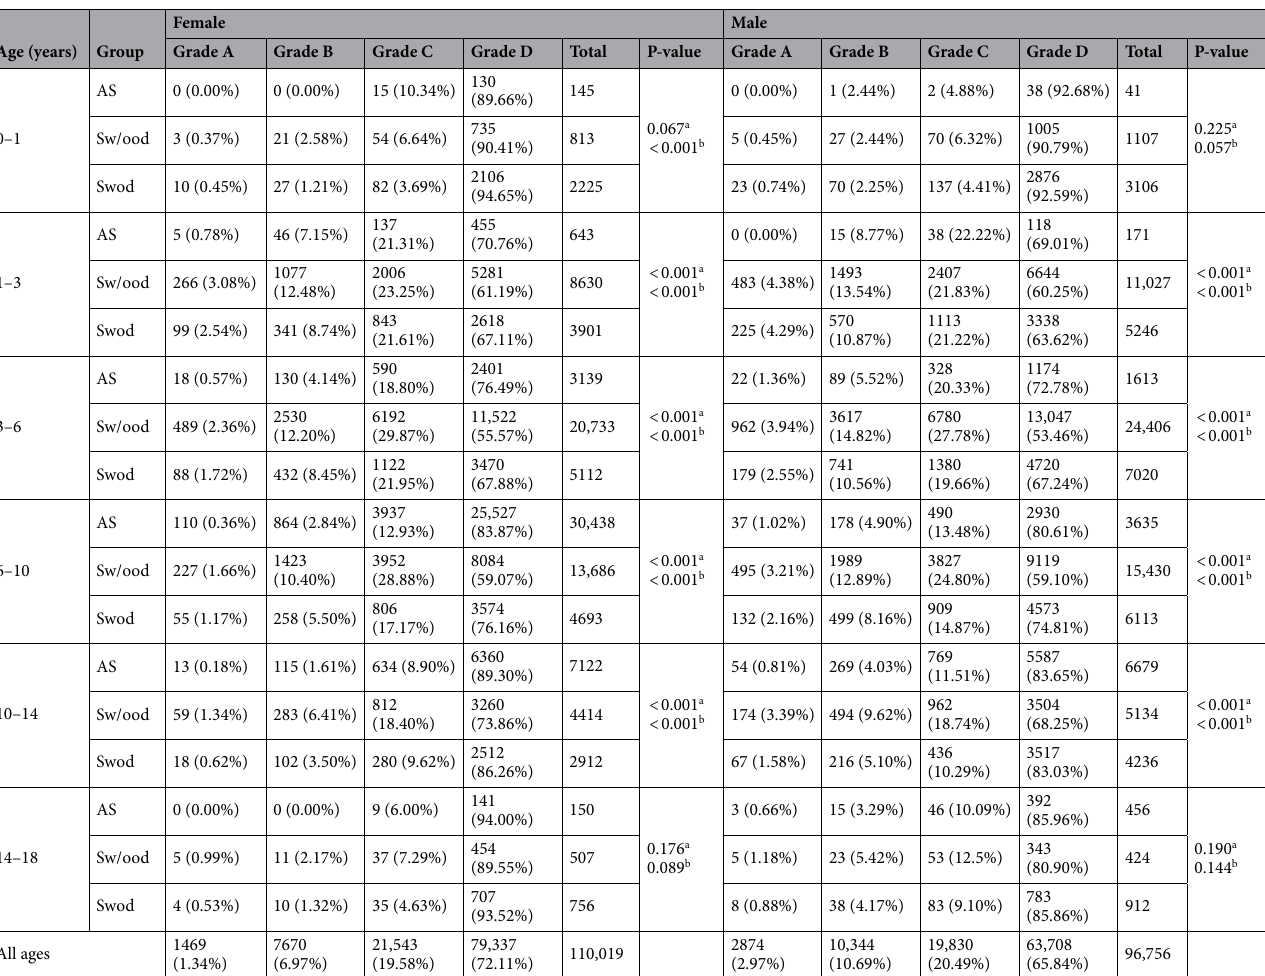
Table 1. Number and prevalence of subjects in different age- and sex-grade subgroups of the AS, Sw/ood, and Swod groups. The superscript a indicates P-values for the comparison between the AS and Sw/ood groups, while b indicates P-values for the comparison between the Sw/ood and Swod groups.